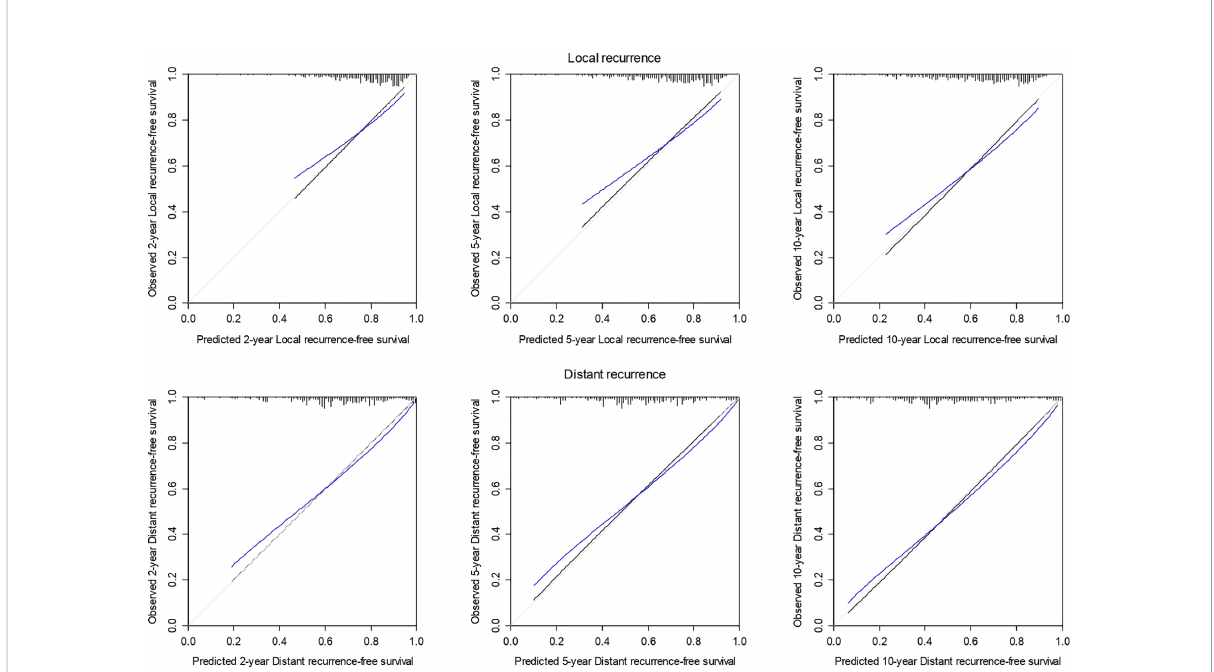
FIGURE 4 Calibration plot of 2-, 5-, and 10-year local and distant recurrence-free survival probability based on 1,000 bootstrapped resamples. Black lines indicate observed calibration, gray lines indicate ideal calibration, and blue lines indicate optimism-corrected